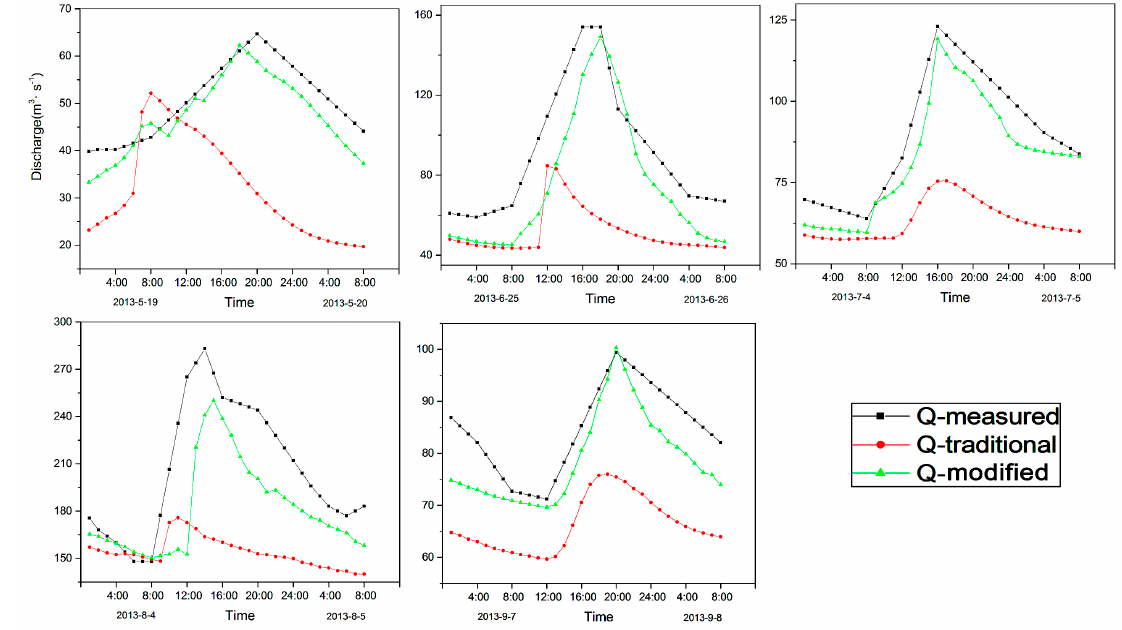
Figure 6. Simulation results of the improved model on an hourly scale during the calibration